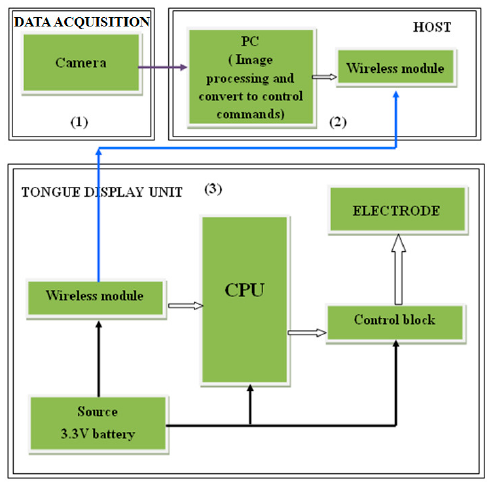
Figure 11. The overall design of the system [30].